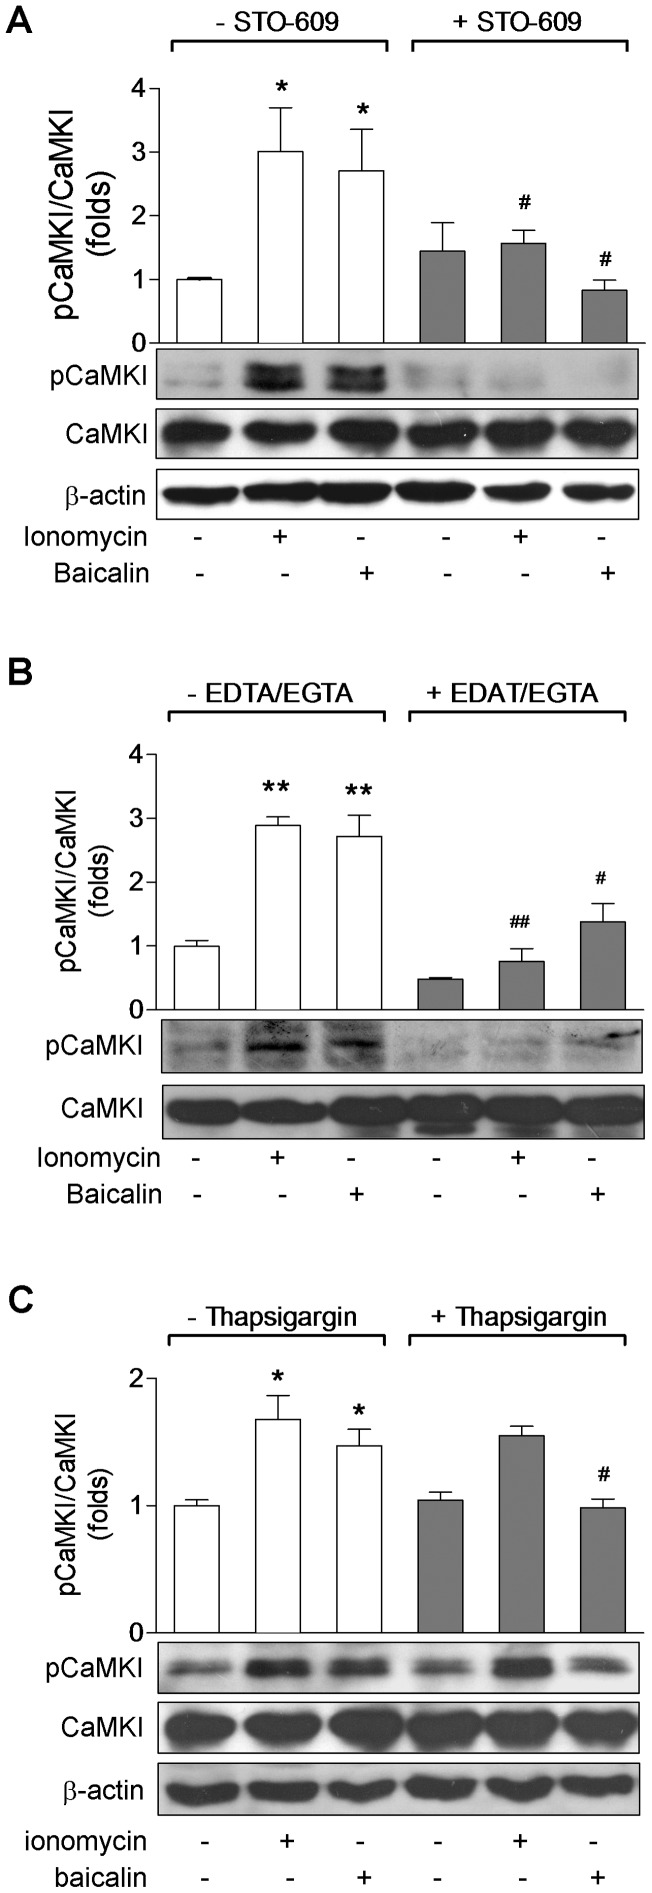
Effects of inhibition of CaMKKβ and intracellular Ca2+ on baicalin-induced phosphorylation of CaMKI in HeLa cells.HeLa cells were treated with 5 µM baicalin for 1 hr or 1 µM ionomycin for 5 min in control medium (open bars), or in the presence of 10 µg/mL of the CaMKKβ inhibitor STO-609 (solid bars, A), Ca2+-free medium containing Ca2+ chelators EDTA and EGTA (solid bars, B), or medium containing 2 µM thapsigarging to deplete intracellular Ca2+ stores (solid bars, C). Phosphorylation of CaMKI at Thr-177 (pCaMKI) as well as total CaMKI and β-actin protein expression were measured by Western blotting. Histograms represent the fold change in the pCaMKI/CaMKI ratio from at least three independent experiments. * p<0.05 and ** p<0.01 compared to control; #
p<0.05 and ##
p<0.01 compared to respective treatment group in control medium. Representative Western blots are shown.